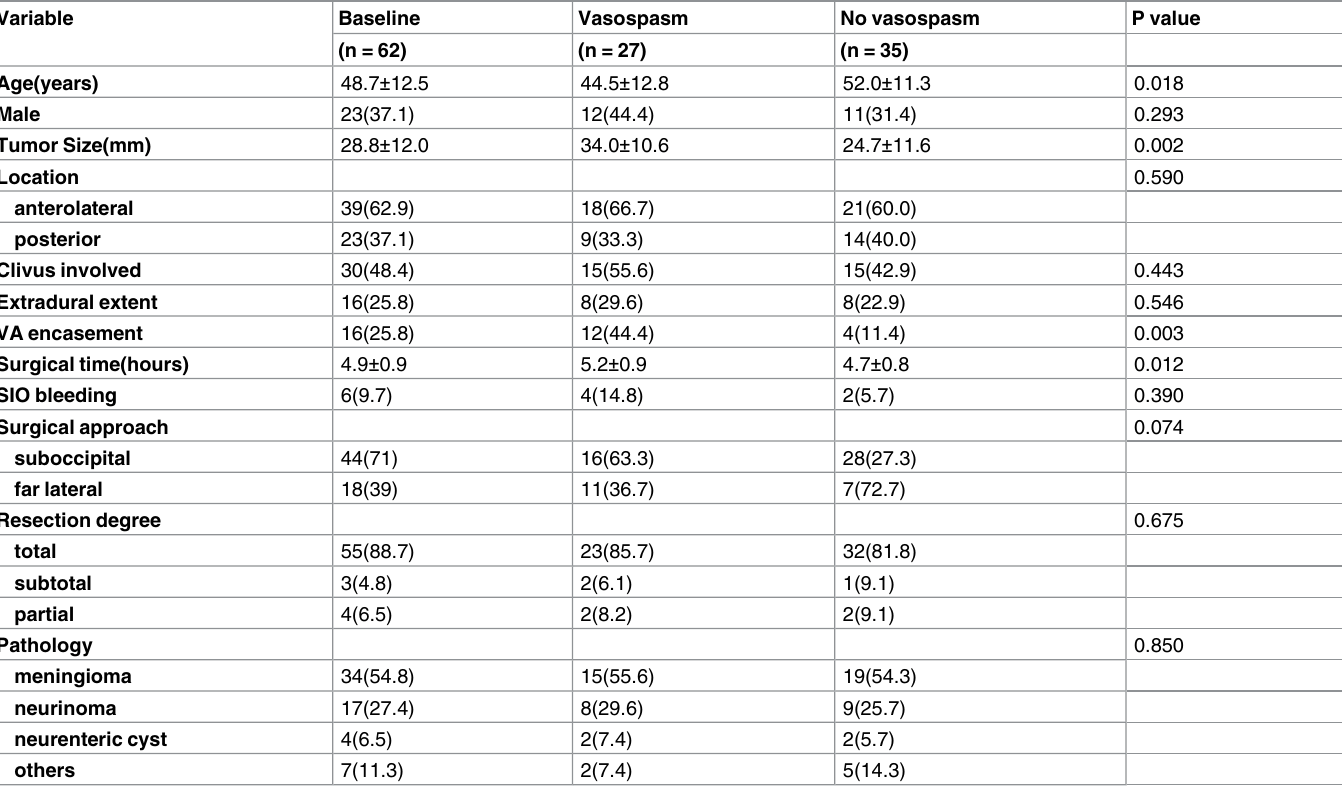
Table 1. Baseline data and clinical variables related to postoperative vasospasm.